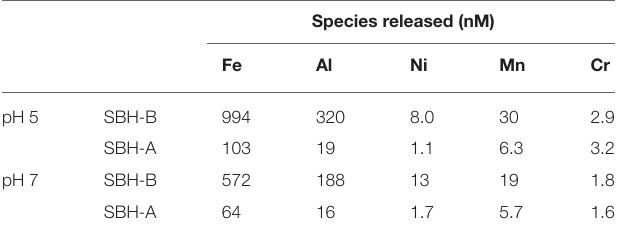
Frontiers in Chemistry |